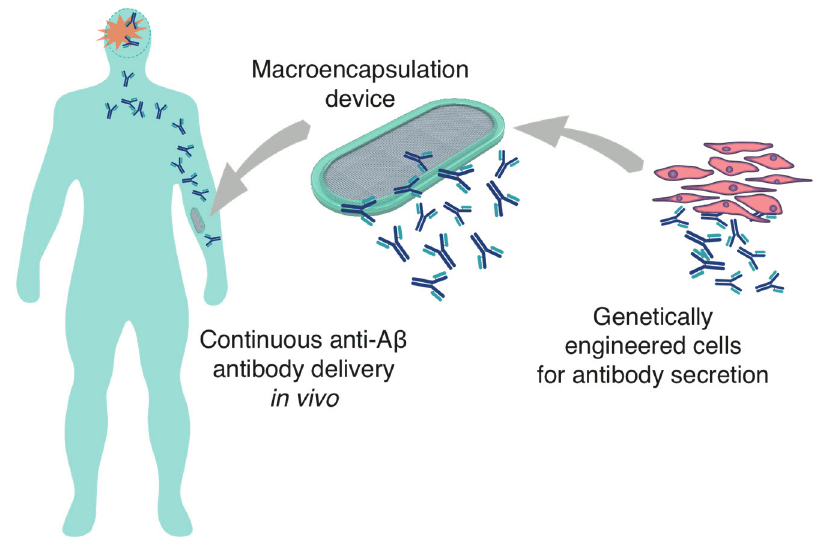
Figure 3. In vivo delivery of encapsulated cells genetically engineered to produce anti-A β antibodies following implantation in the subcutaneous